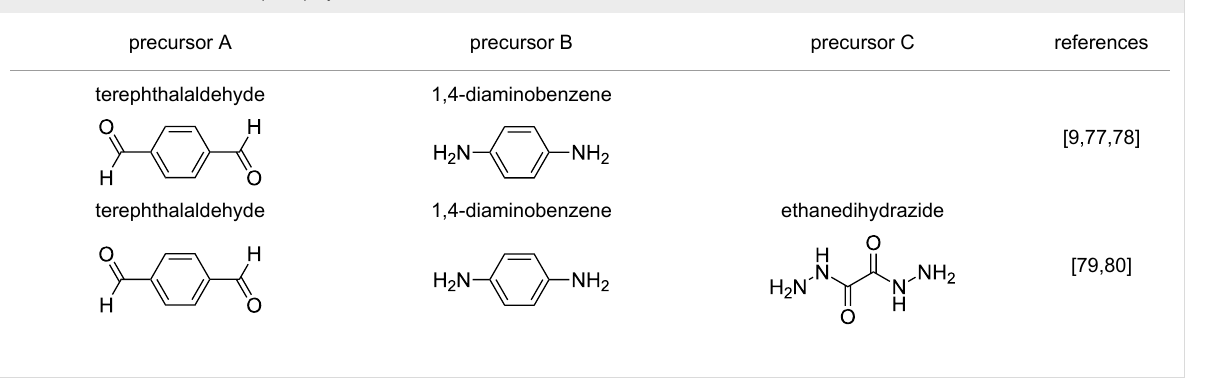
Table 10: Precursors used to deposit polyimine thin films.